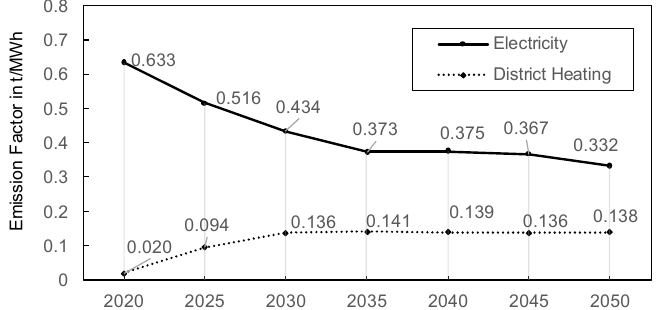
Figure 6. Emission factor of electricity and district heating (marginal) in tons of CO 2 per MWh.